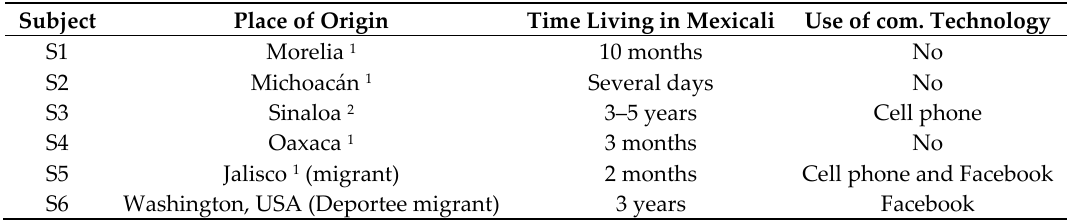
Table 1. Participants’